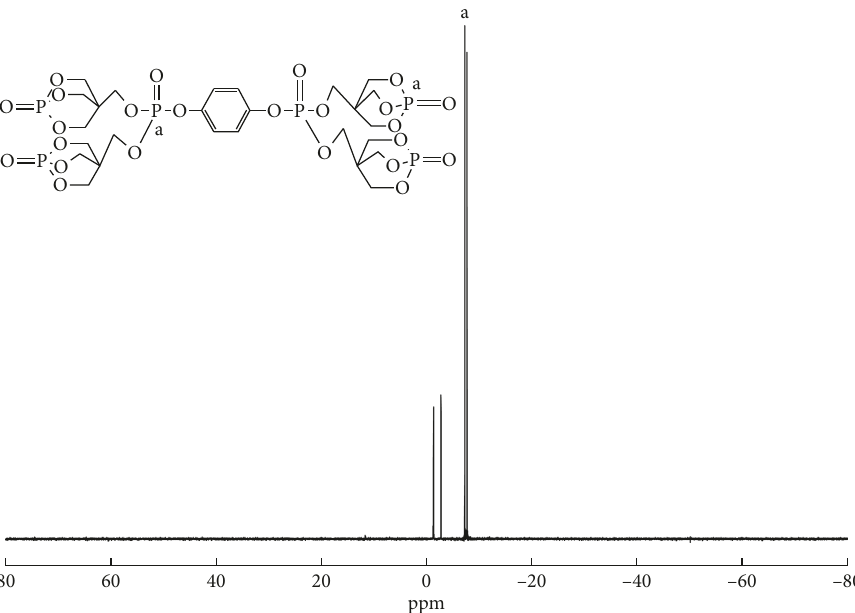
Figure 3: The 31 P NMR spectra of